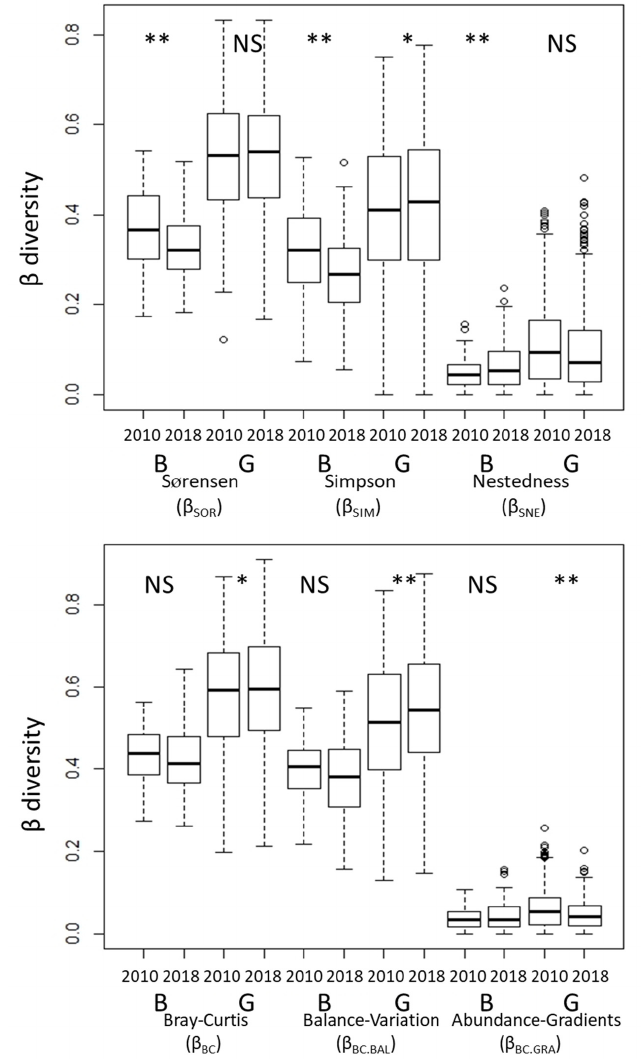
Figure 3. Comparison of β -diversity metrics among transects in each census. The exact Wilcoxon signed-rank test was used to compare the 2010 and 2018 data. NS, not significant; * p < 0.05; ** p < 0.01. B: Betula forests, G: Grasslands .